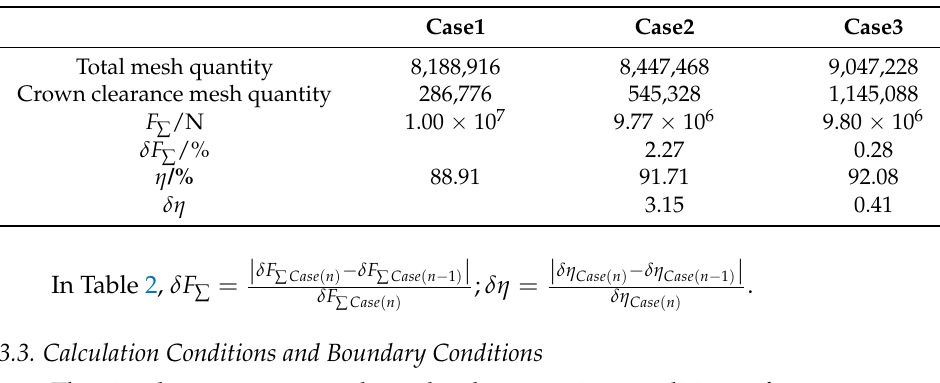
Table 2. Mesh sensitivity